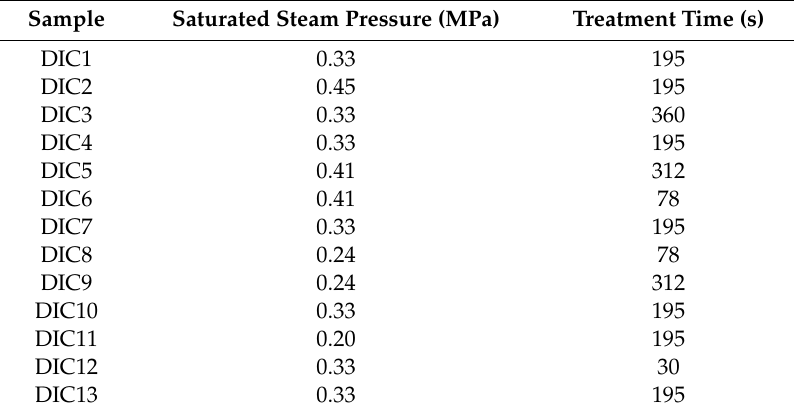
Table 6. Vetch flour DIC processing